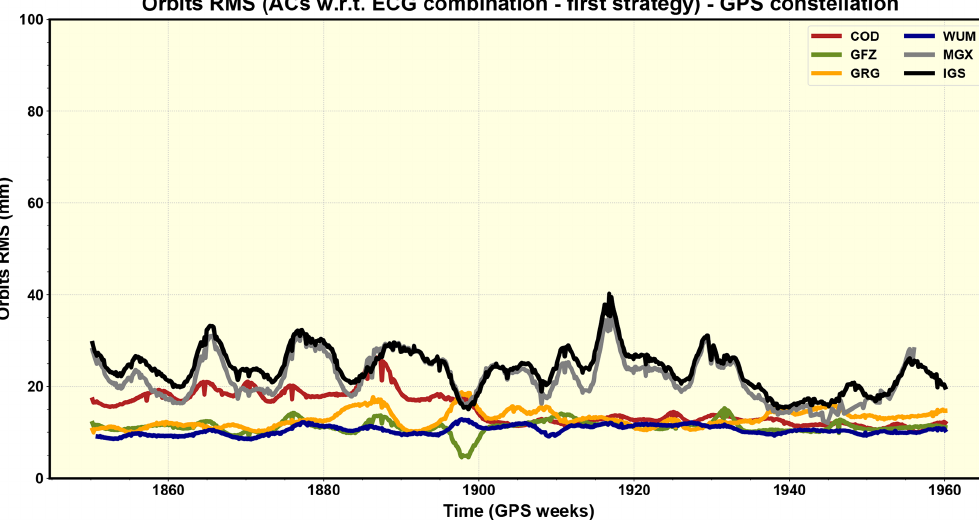
Figure 3. RMS values with respect to the individual ACs’ MGEX submission for GPS orbits and the GPS ECG combination result computed by ERP strategy